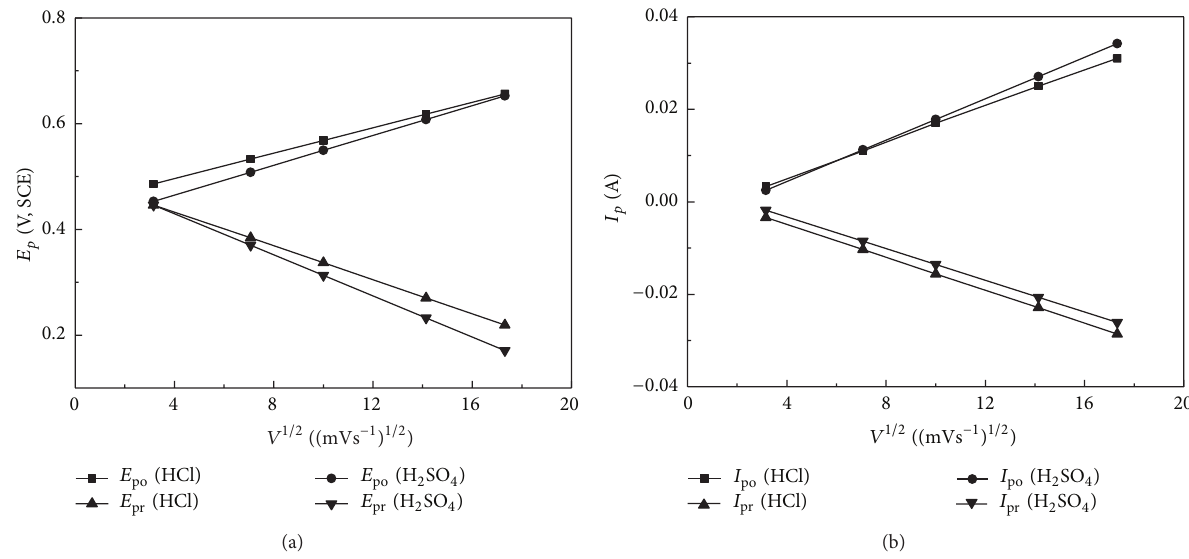
Figure 8: Relationship graphs of (a) peak potential, 𝐸 𝑝 , and (b) peak current, 𝐼 𝑝 , for oxidation and reduction from cyclic voltammograms in Figure 6 to square root of scan rates in 1MHCl and 1MH 2 SO 4